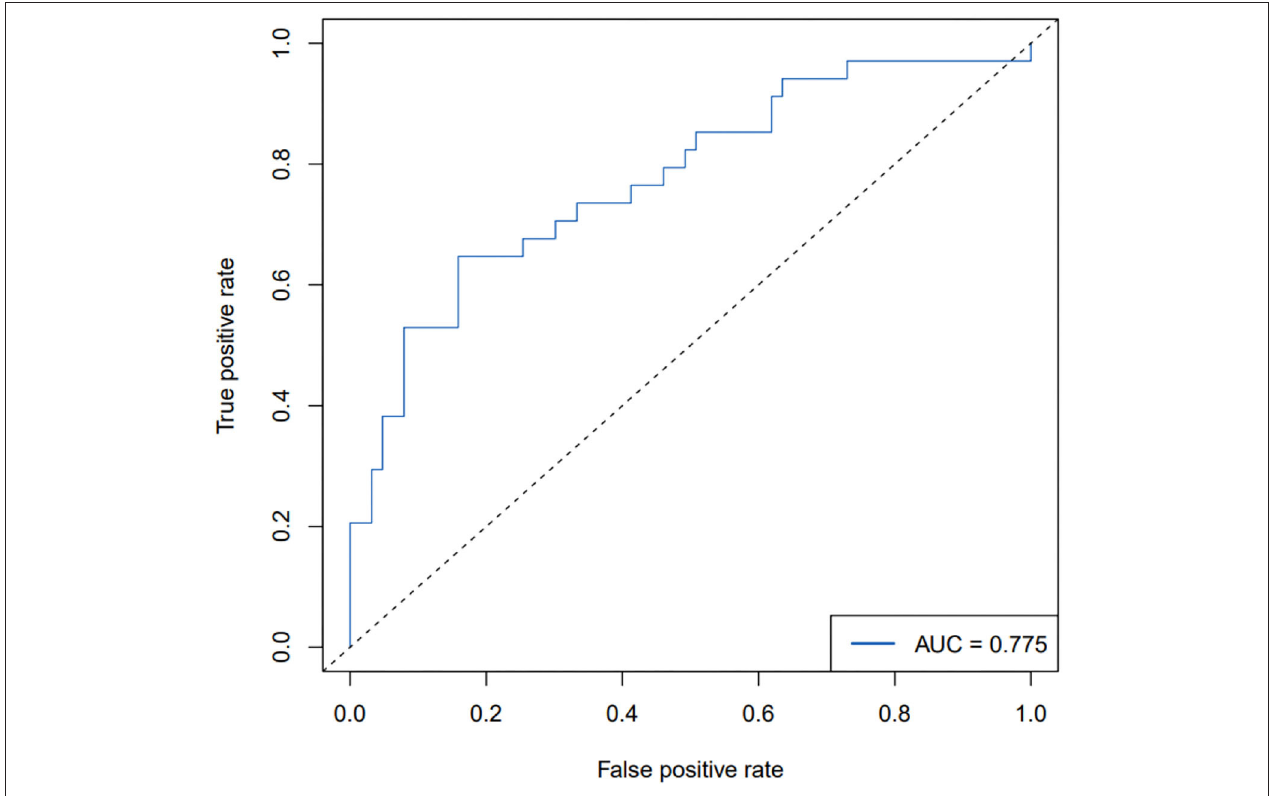
FIGURE 5 | Receiver operating characteristic (ROC) curve of PEF in the validation